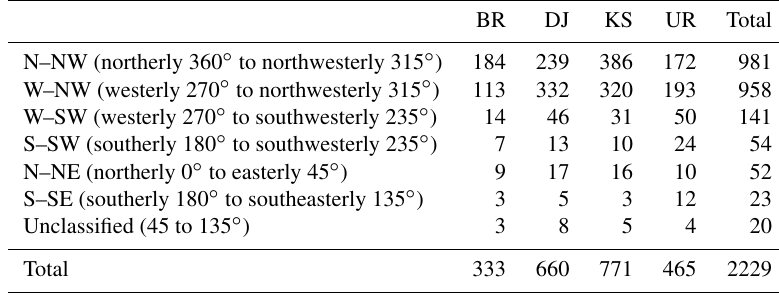
Table 1. Azimuthal dependence of ADS transport path.